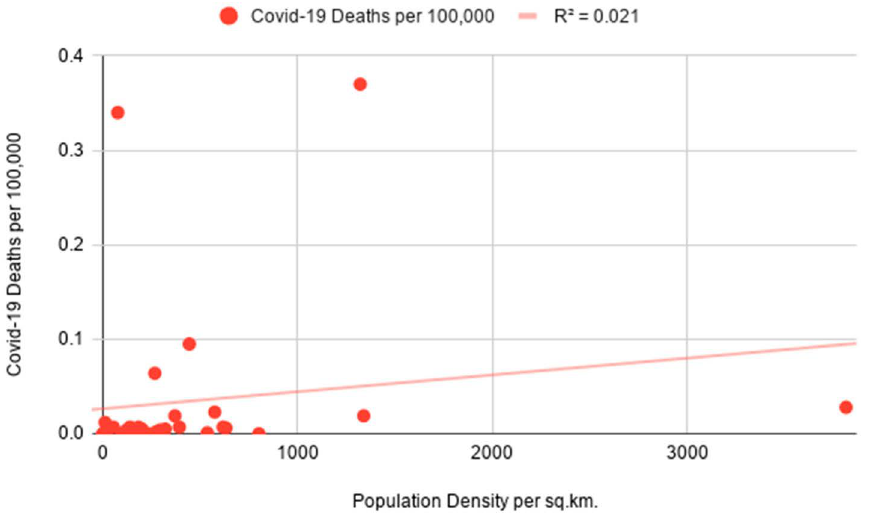
Figure 4. Simple linear regression with population density as an independent variable and Covid-19 deaths as a dependent variable for China’s administrative